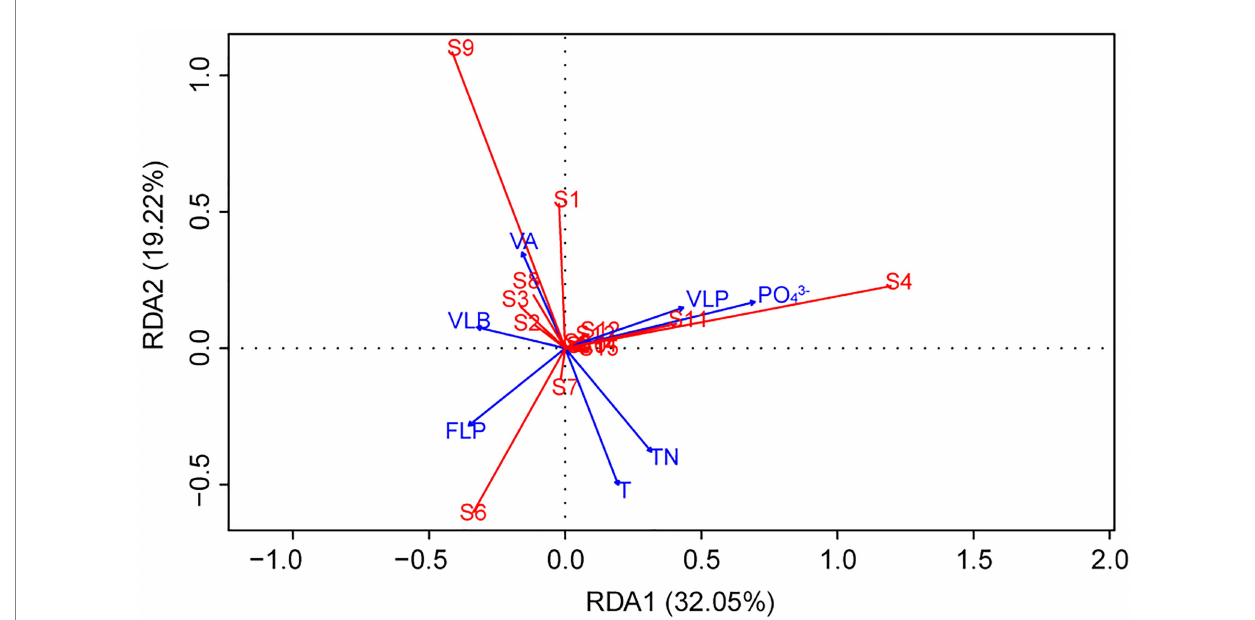
FIGURE 7 Redundancy analysis (RDA) ordination plot describing the phytoplankton community composition (response variables, in red) in relation to viral and environmental variables (explanatory variables, in blue). (S1, Cyclotella sp.; S2, Navicula minima ; S3, Fragilaria brevistriata ; S4, Melosira granulata var. angustissima ; S5, Ceratium hirundinella ; S6, Microcystis sp.; S7, Phormidium tenue ; S8, Anabaena azotica ; S9, Anabaena circinalis ; S10, Phacus sp.; S11, Chlorella vulgaris ; S12, Chroomonas acuta ; S13, Cryptomonas erosa ; S14, Cryptomonas sp.; and S15,